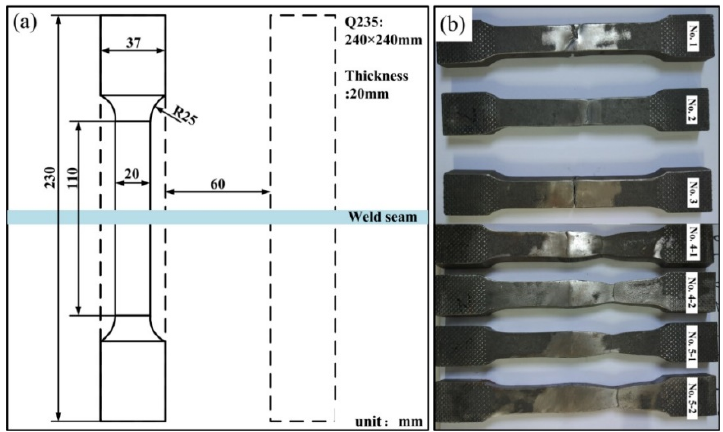
Figure 7. Morphology of the tensile samples: ( a ) Size and sampling position of the tensile samples. ( b ) Fractured samples.